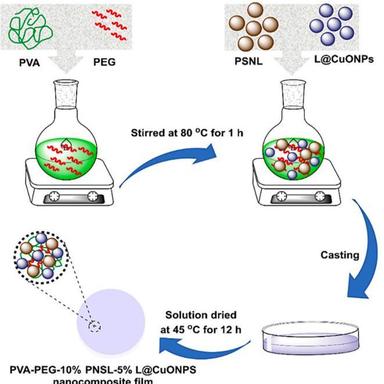
Schematic presentation of nanocomposite film preparation.